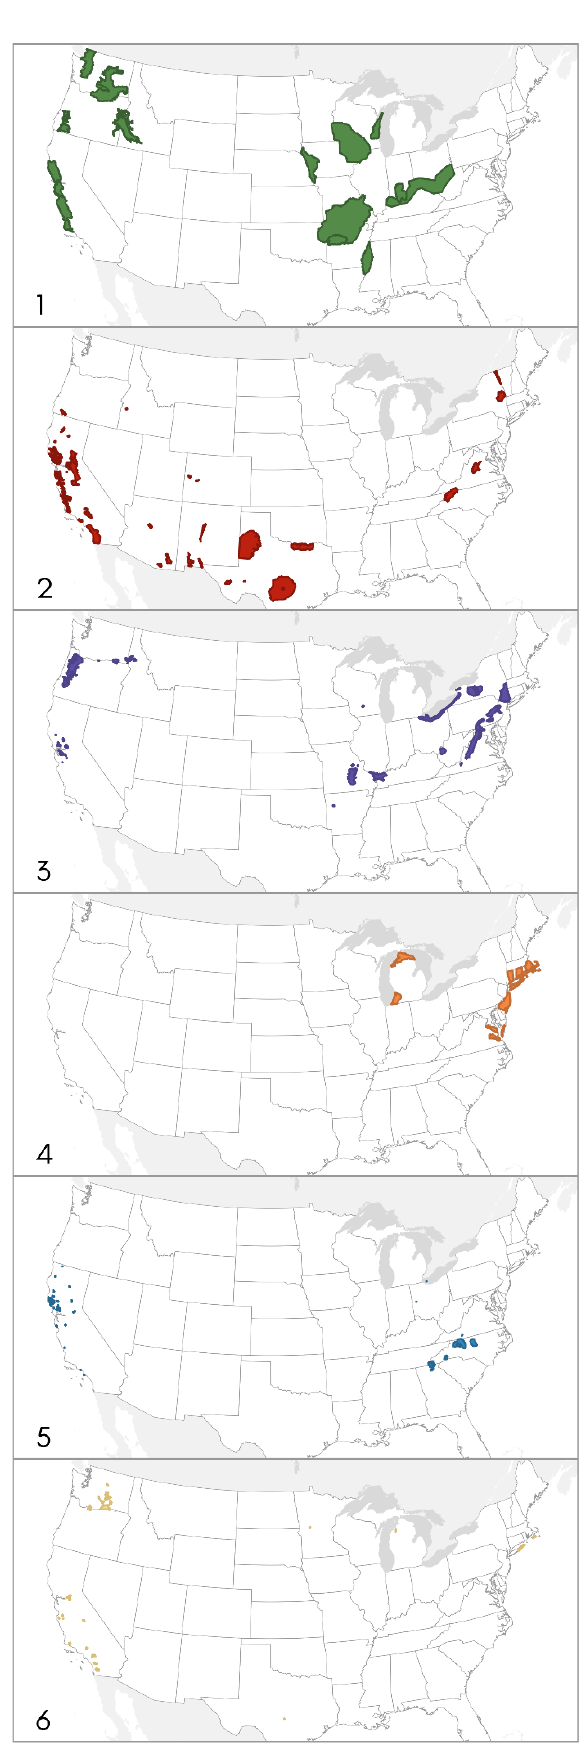
Figure 2 . Maps of AVAs in each